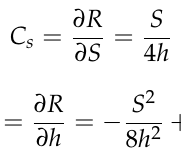
Component of Uncertainty Symbol Calculation